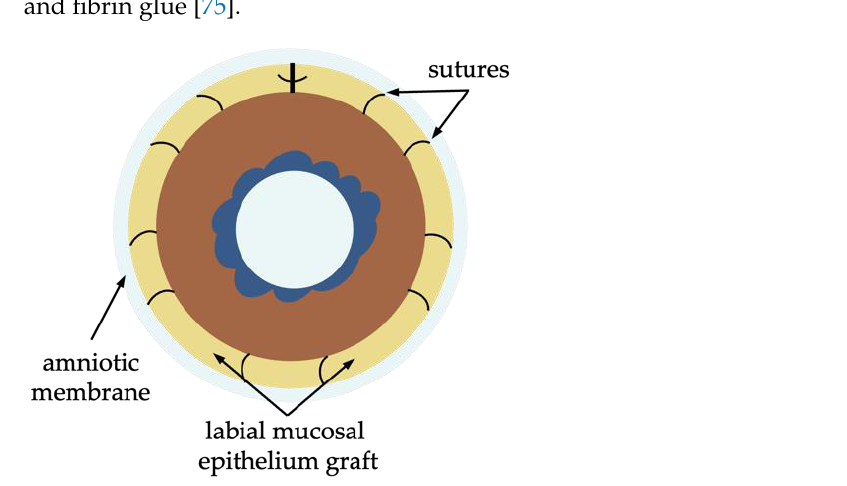
Figure 11. Schematic representation of paralimbal oral mucosal epithelium transplantation (PLOMET) for use in bilateral LSCD. The labial mucosal epithelium graft is sutured 2–3 mm away from the corneal limbus surrounding the affected cornea.